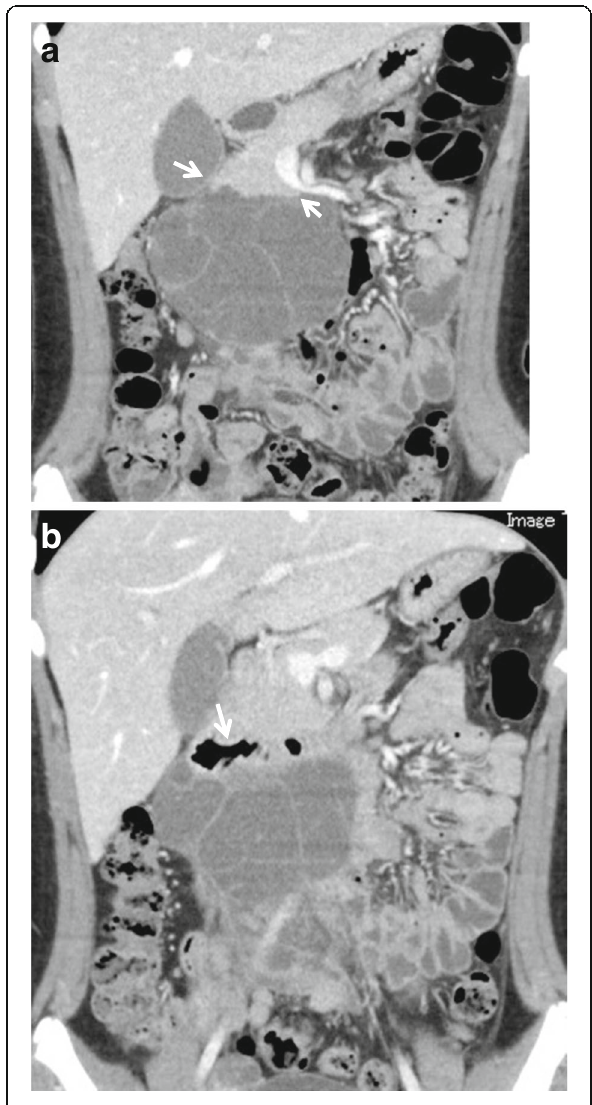
Fig. 1 Contrast CT revealed a well-circumscribed multicystic mass measuring 9.5×5.8×10.0 cm in the retroperitoneal region. The mass, filled with serous fluid without hemorrhage or abscess, was suspected to adhering and stretching the pancreas head ( a , arrow : pancreas head) by the beak sign. The tumor was suspected to adhering the duodenum ( b , arrow :